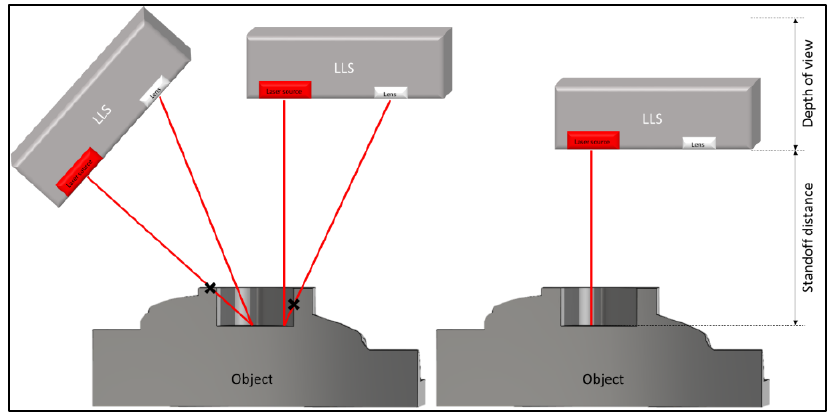
Figure 3. The physical constraints of the probing system related to its positioning relative to the measured object. On the left is the reachability constraint and on the right is the scan depth.